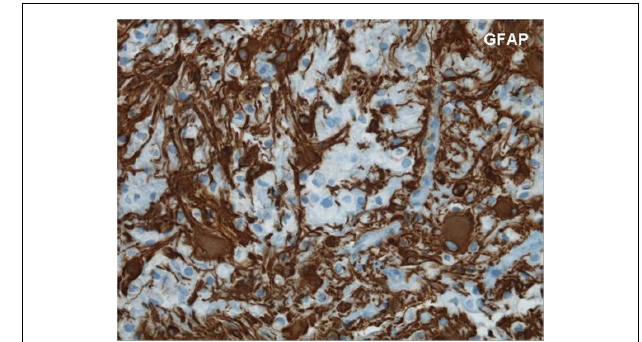
FIGURE 3 | H and Estaining shows brain parenchyma with focal lymphocytic infiltrates, numerous macrophages and reactive gliosis (A) and perivascular lymphocytic infiltrates (B,C).